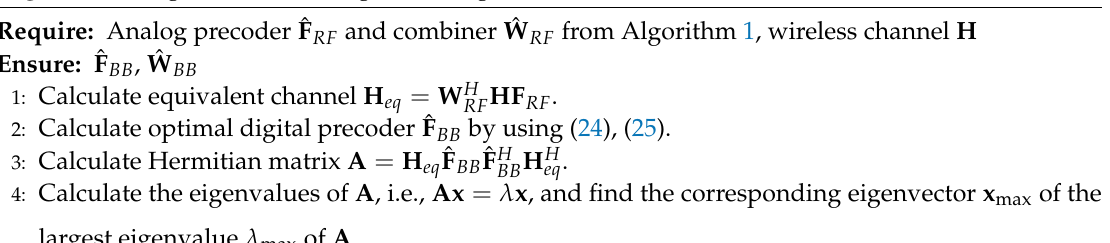
Algorithm 2 Digital beamforming matrix